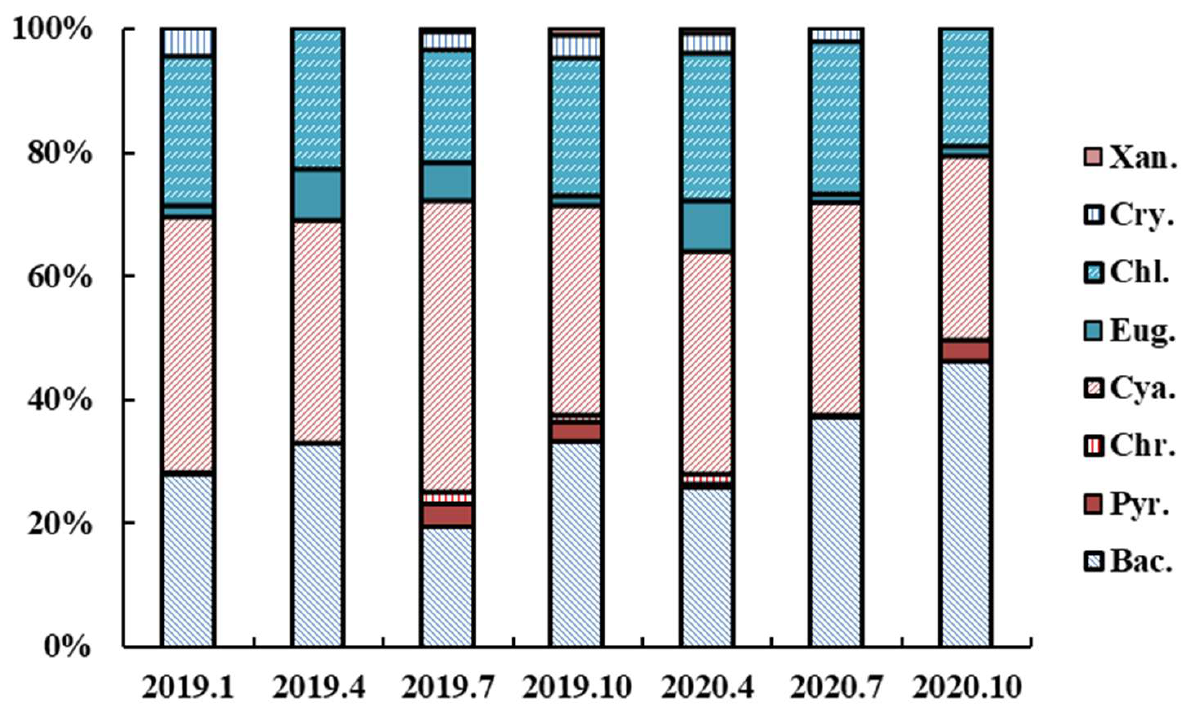
Figure 4. Changes in relative densities of different phytoplankton taxa during sampling periods.